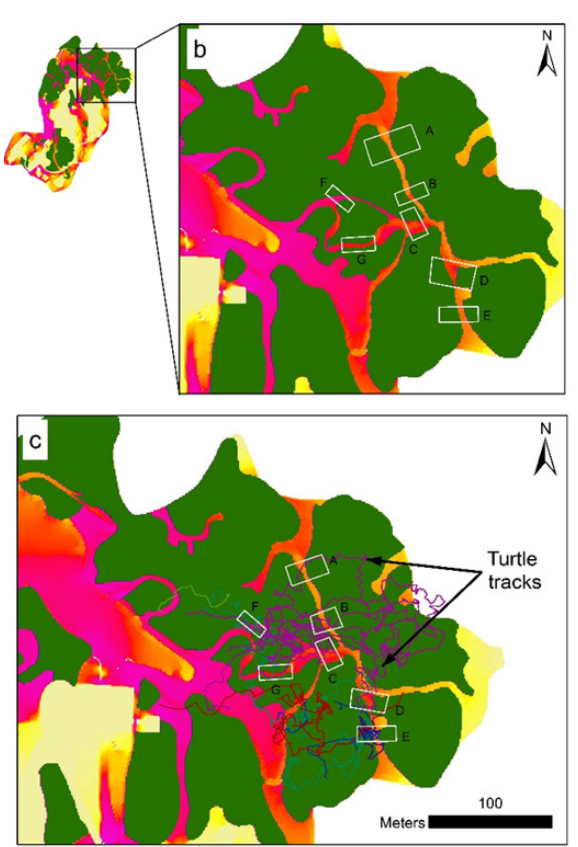
(white boxes) from figure 4a. c) Turtle tracks validating the predicted corridors in figure